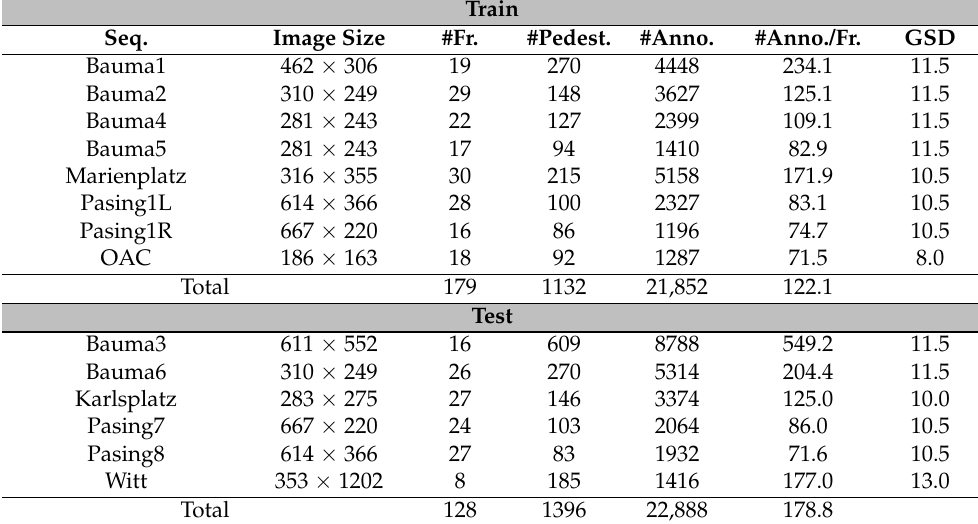
Table 3. Statistics of the AerialMPT